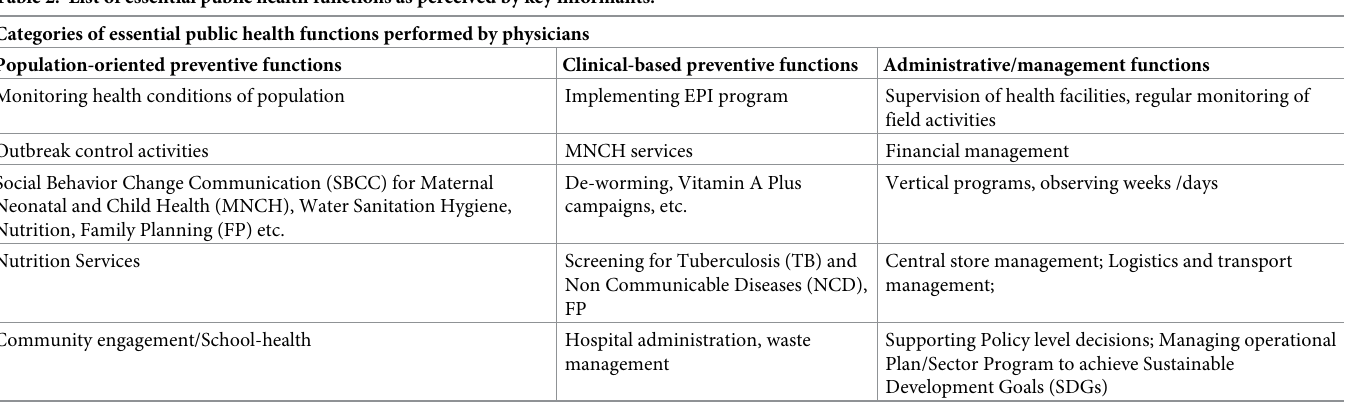
Table 2. List of essential public health functions as perceived by key informants. Categories of essential public health functions performed by